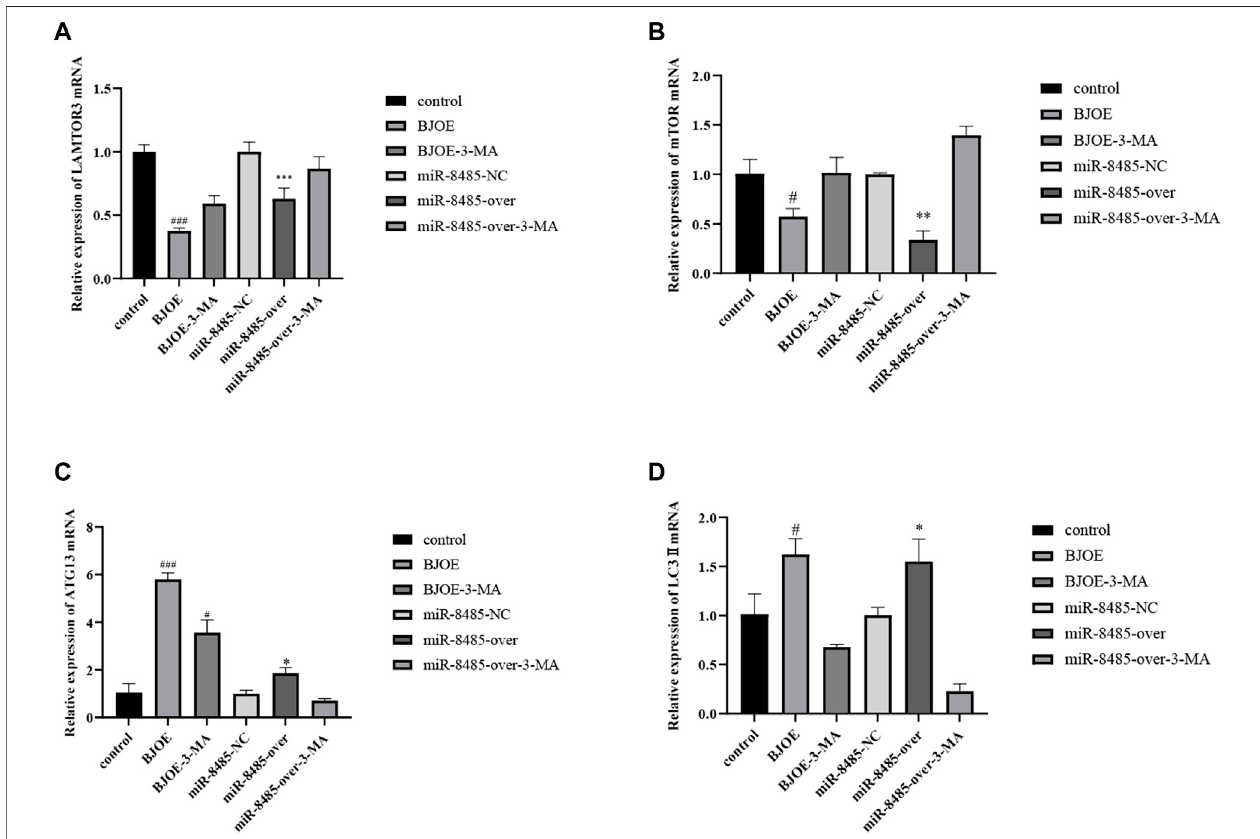
FIGURE 7| Effects of BJOE and overexpressed miR-8485on autophagy gene mRNA. [ A – D Effectof BJOE, overexpression ofmiR-8485and autophagy inhibitor on relative mRNA expression of LAMTOR3, mTOR, ATG13 and LC3II, All the p values were compared with the control. All the p values were compared with the control group (n = 3). Data were shown as mean ± SD, # p < 0.05, ### p < 0.001; * p < 0.05, ** p < 0.01, *** p <